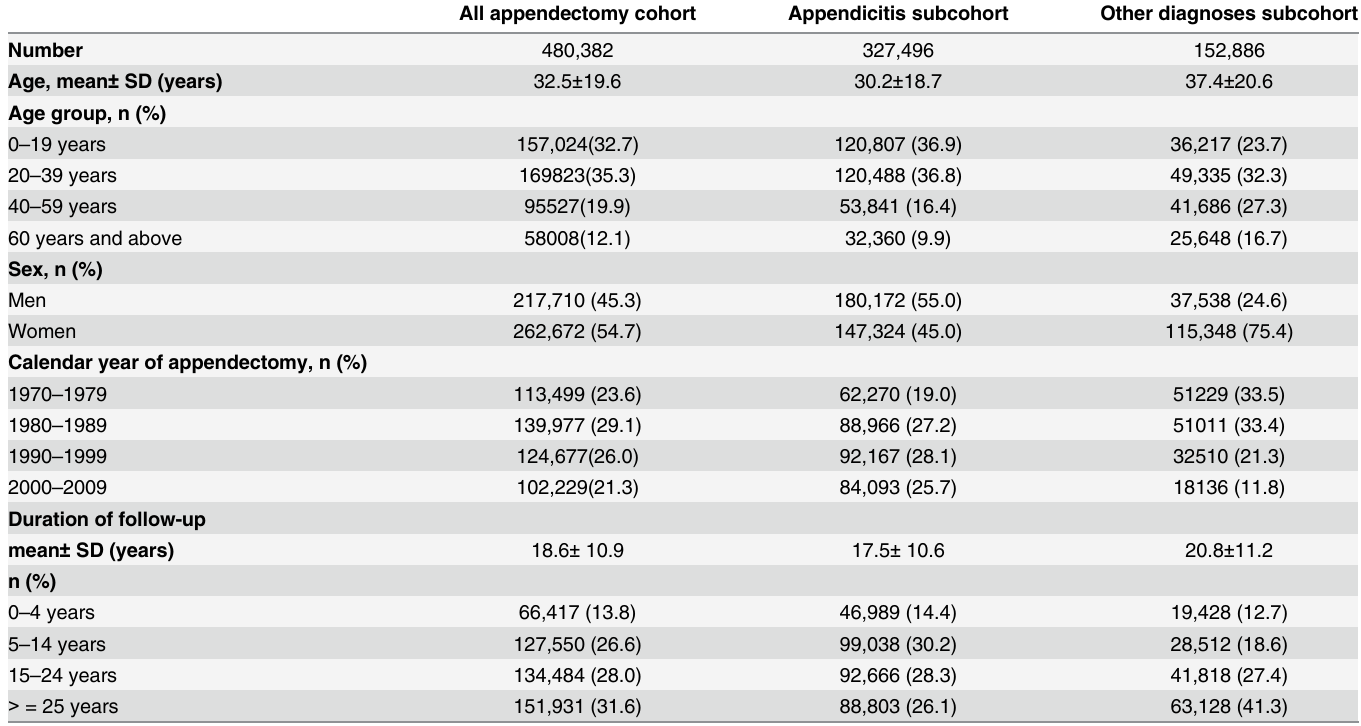
Table 1. Description of appendectomies in Sweden during 1970 – 2009, grouped by underlying diagnoses.